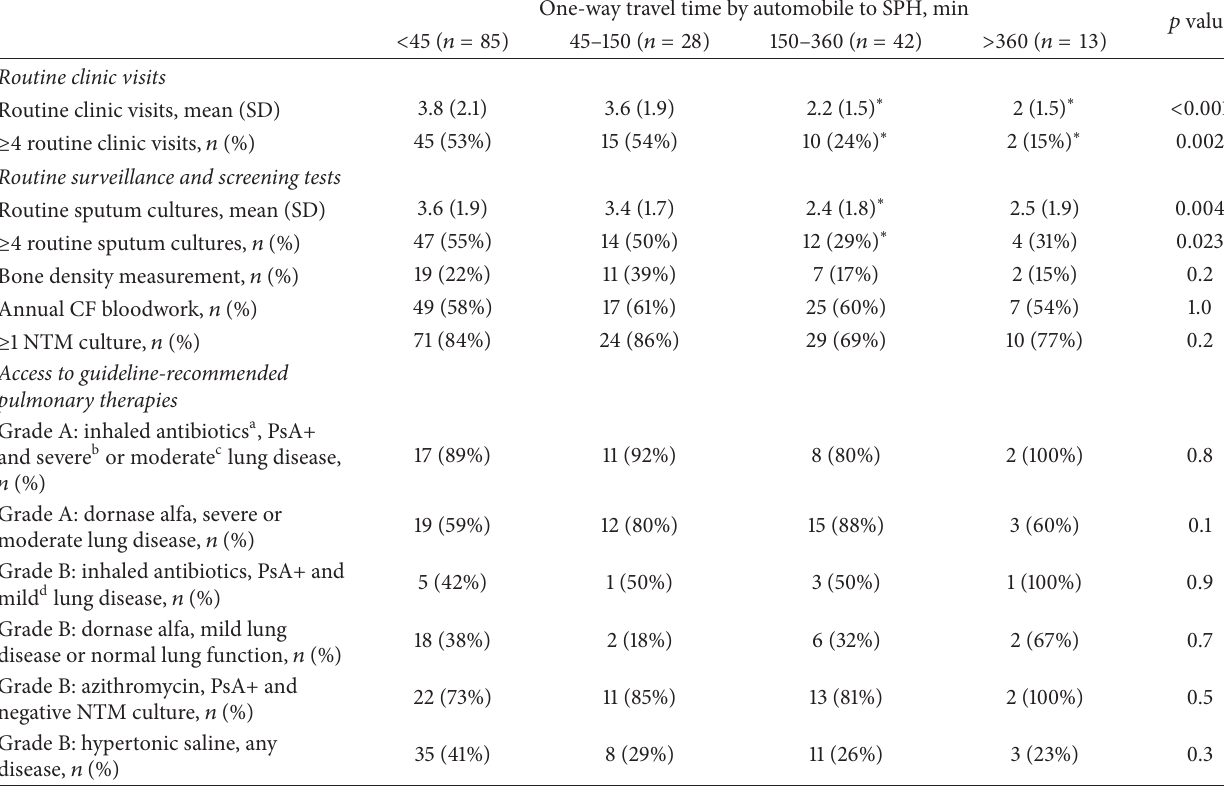
Table 2: Access to clinic, surveillance and screening tests, and guideline-recommended treatments by travel time.